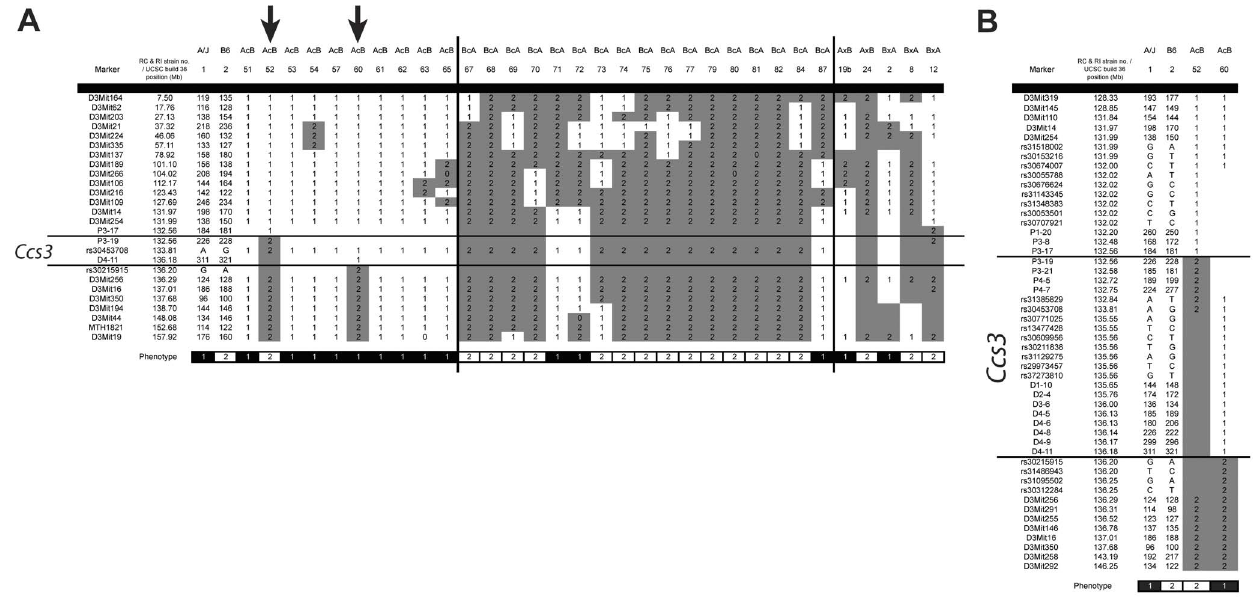
Figure 1. Haplotype structure at the Ccs3 locus in recombinant congenic (RCS) and recombinant inbred (RI) strains. A . Chromosome 3 haplotypes of AcB/BcA strains are displayed along with their resistance (white) or susceptibility (black) status for AOM-induced CRC (bottom strip). The B6-derived chromosomal segments are indicated in grey (2), while the A haplotypes are annotated in white (1). Arrows ( Q ) indicate key RCS strains delineating the minimum chromosomal interval for the Ccs3 locus. B . Detailed haplotype map of the Ccs3 locus, including delineation of the proximal and distal boundaries by high-density SNP genotyping in key informative congenic strains (AcB52, AcB60).